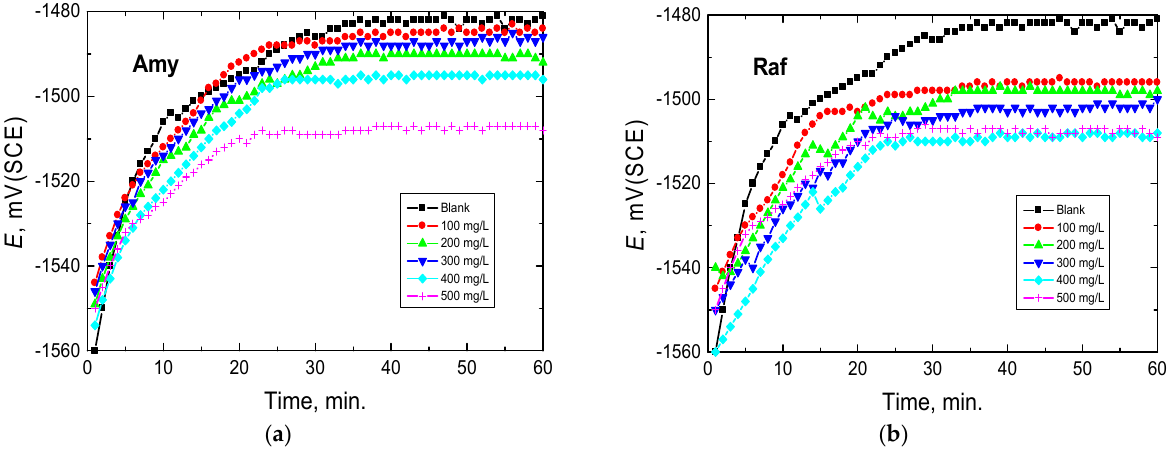
Figure 2. Potential ‐ time curves for Al in 0.1 M NaOH medium and with, ( a ) Amygdalin (Amy), and Figure 2. Potential-time curves for Al in 0.1 M NaOH medium and with, ( a ) Amygdalin (Amy), and ( b ) Raffinose (Raf) at 298 K. ( b ) Raffinose (Raf) at 298 K.